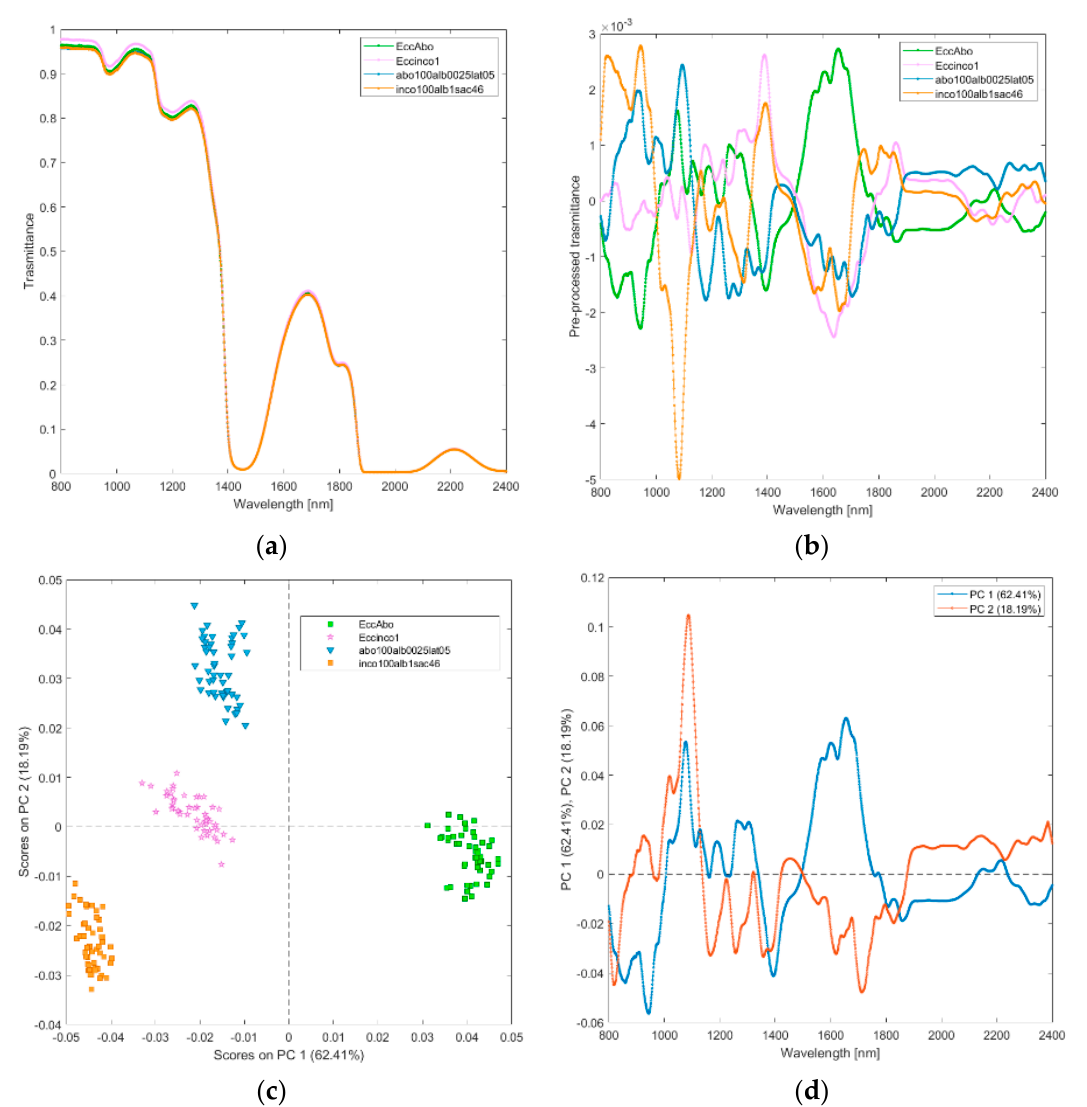
Figure 3. Average raw ( a ) and pre-processed ( b ) transmittance spectra for incobotulinum A toxin (inco100alb1sac46) and abobotulinum A toxin (abo100alb0025lat05), and their excipients (EccInco, EccAbo). PC1 − PC2 score plot ( c ) and loading plot of PC1 and PC2 ( d ) for incobotulinum A toxin (inco100alb1sac46), abobotulinum A toxin (abo100alb0025lat05), and their excipients (EccInco, EccAbo). (iii) Solutions of incobotulinum A toxin (inco100alb1sac46), equiactive